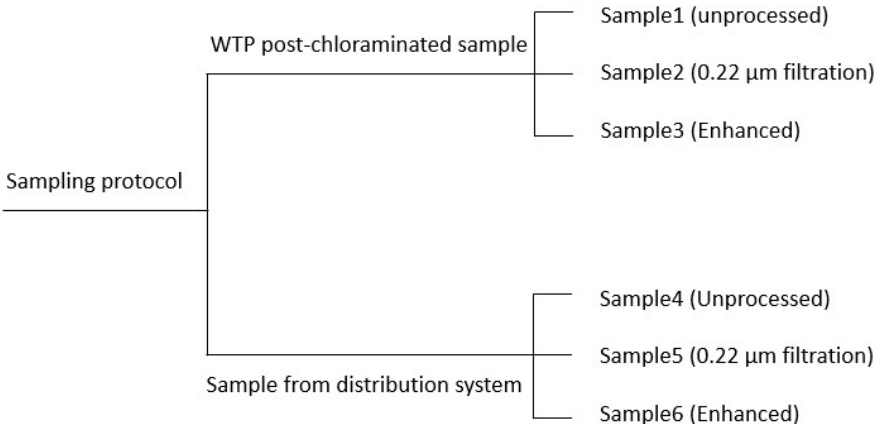
Figure 2. Sample preparation using the grab water collected from WTP and the distribution sys- tem.